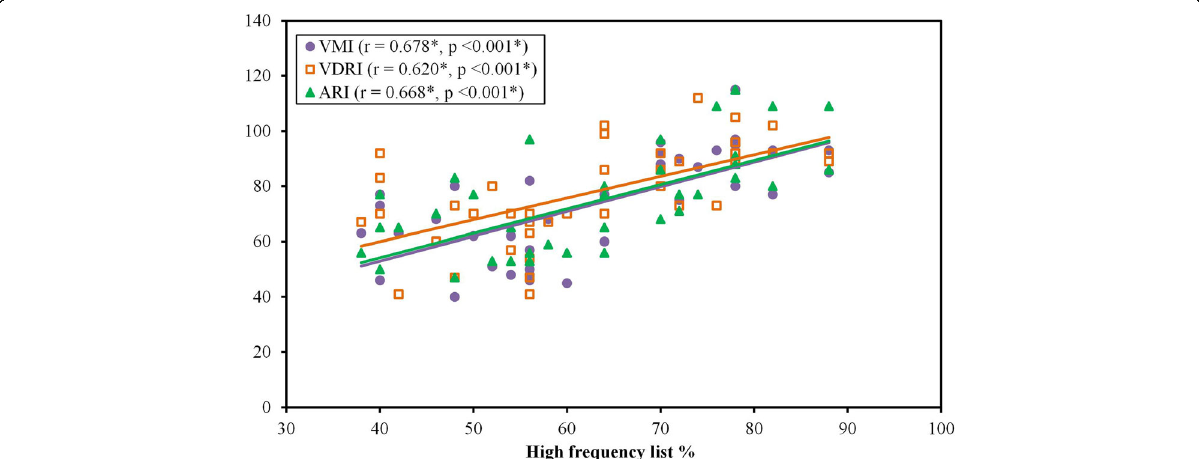
Fig. 5 Scatter diagram for the correlation between high frequency list scores and TOMAL-2